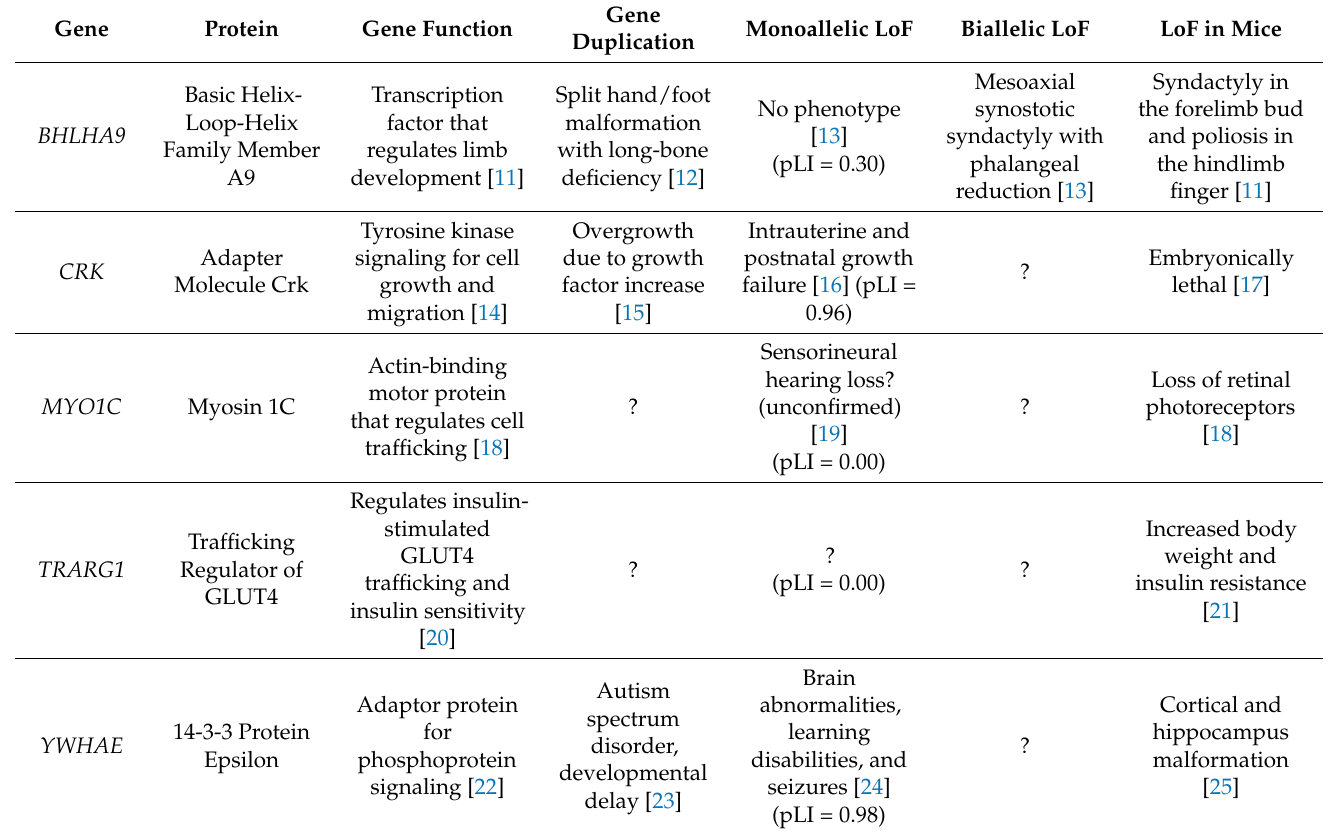
Table 1. Summary of reported phenotypes in human and mice for the affected genes in the clinical case. “?”, unknown or not